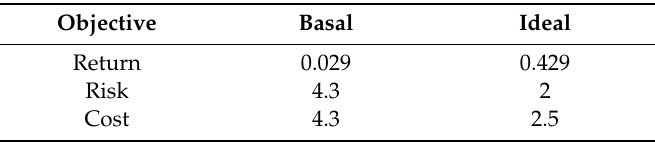
Table 5. Extremes of the